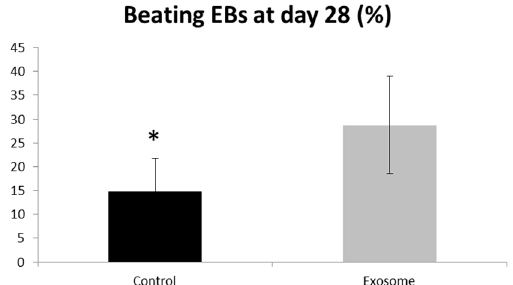
Figure 7 . Exosome implication on beating EBs. EBs were seeded on a 6-well plate. The number of contracting EBs was calculated as a percentage of the total number of EBs. EBs treated with exosomes were compared to control,* p = 0.05. Control ( n = 5), exosome ( n = 5).